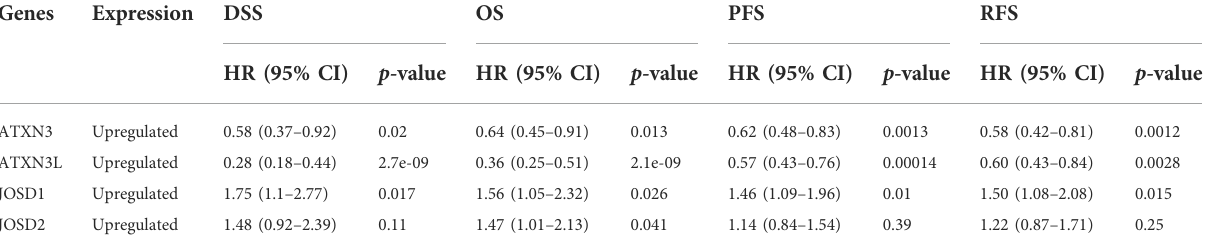
TABLE 1 Prognostic analysis of the MJDs in Kaplan – Meier plotter.